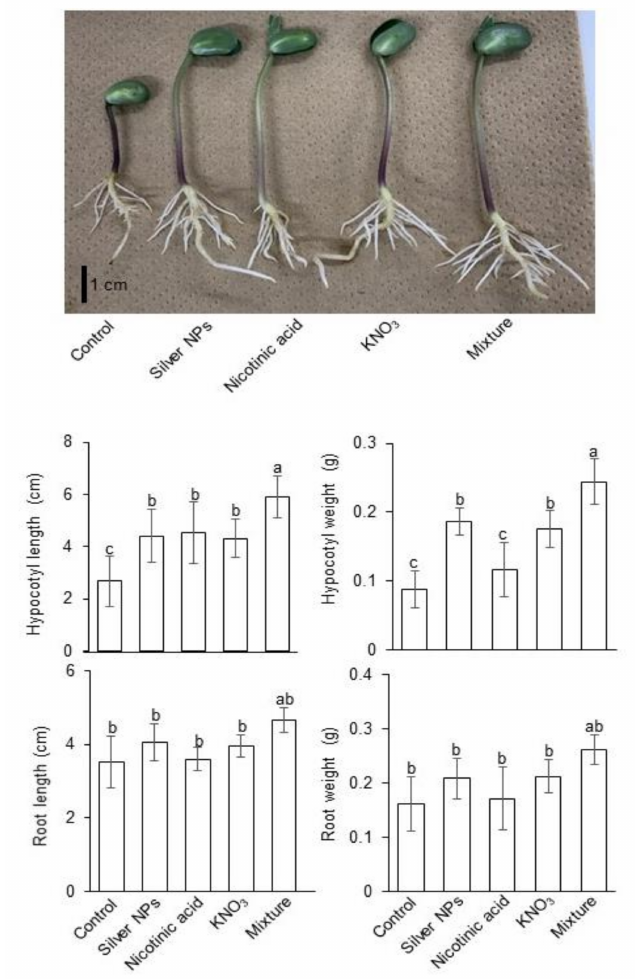
Figure 1. Effects of silver NPs, nicotinic acid, and KNO 3 on the morphology of soybean seedlings. Two-day-old soybeans were treated with 5 ppm silver NPs, 8 µ M nicotinic acid, 0.1 mM KNO 3 , and 5 ppm silver NPs / 8 µ M nicotinic acid / 0.1mM KNO 3 . After treatments, root length / weight and hypocotyl length / weight were measured at two days of stress. Data are presented as the mean ± S.D. from three independent biological replicates. Mean values of each data point with different letters are significantly different according to one-way ANOVA Duncan’s Multiple Range test ( p < 0.05). Scale bar indicates 1